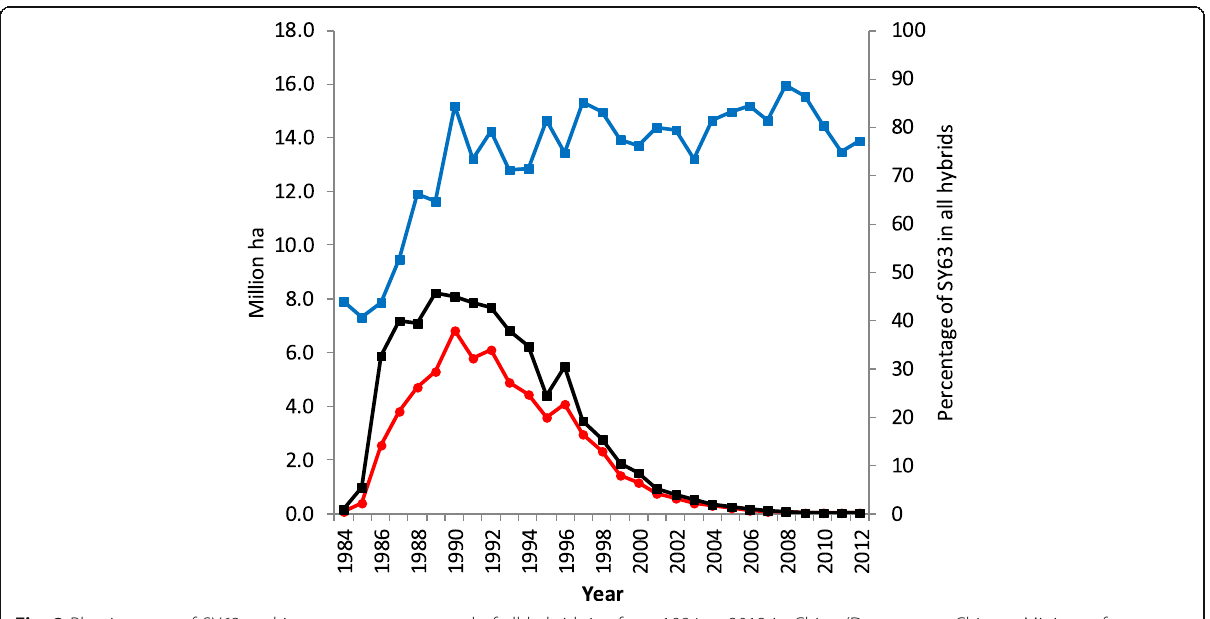
Fig. 2 Planting area of SY63 and its percentage as a total of all hybrid rice from 1984 to 2012 in China (Data source: Chinese Ministry of Agriculture and Wu, et al. 2011).